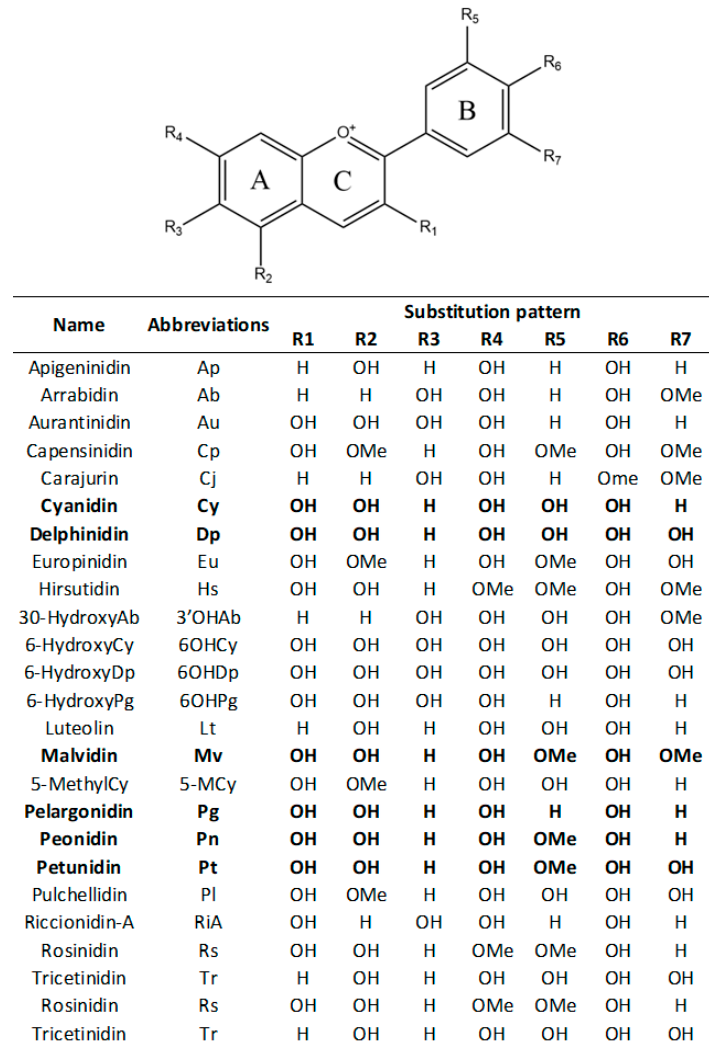
Figure 1. Chemical scaffold of anthocyanin compounds and their relative substituents. In the table, the most common anthocyanidins are reported in bold.